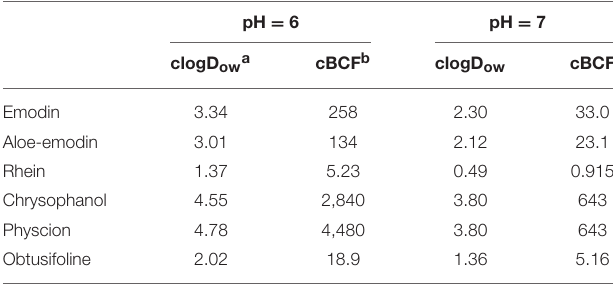
TABLE 3 | Estimated values of BCF of typical